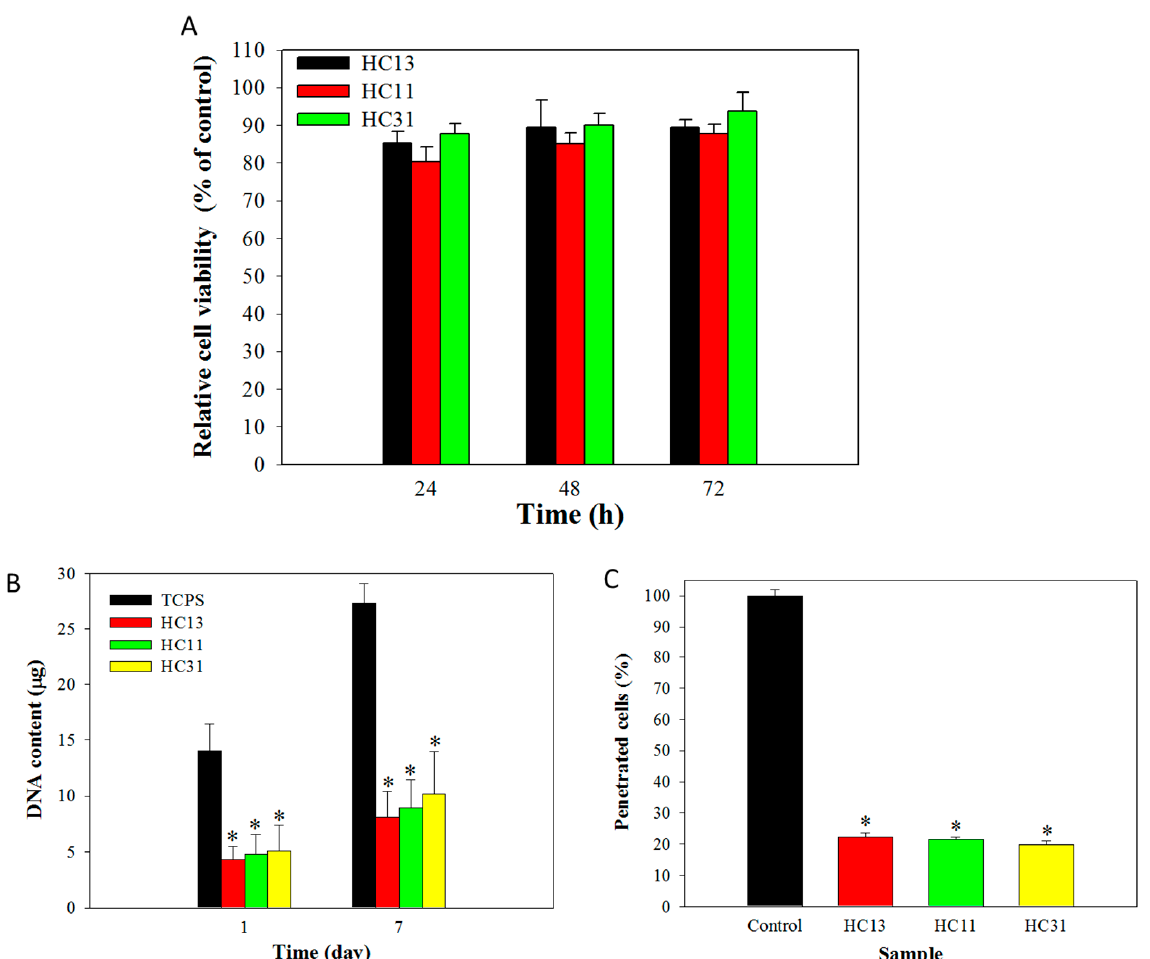
Figure 5. ( A ) The cytotoxicity of HA/CMC hydrogel prepared at 1/3 (HC13), 1/1 (HC11) and 3/1 (HC31) mass ratios of HAMA/CMCMA. The 3T3 fibroblasts were cultured with 24-h extract of hydrogel for 24, 48 and 72 h and fresh cell culture medium was used as a control to calculate the relative cell viability from WST-1 assay. ( B ) The DNA contents for 3T3 cells cultured on tissue culture polystyrene (TCPS) or HA/CMC hydrogel for 1 and 7 days. ( C ) The penetration of 3T3 cells by placing HA/CMC hydrogel in a cell insert of Transwell migration assay for determining the DNA content of penetrated cells in 24 h. The control is cell insert only. * p < 0.05 compared with TCPS or control.